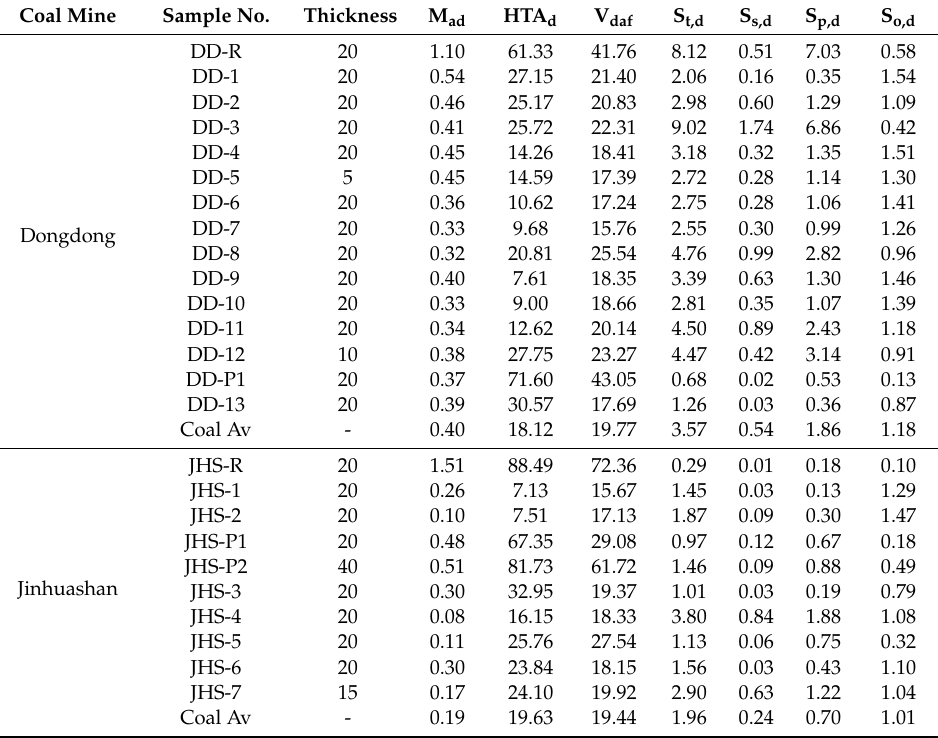
Table A1. Coal bench thickness (cm), proximate analysis (%), and forms of sulfur (%) of the No. 5 coals from Dongdong and Jinhuashan coal mines, Weibei coal field. Coal Mine Sample